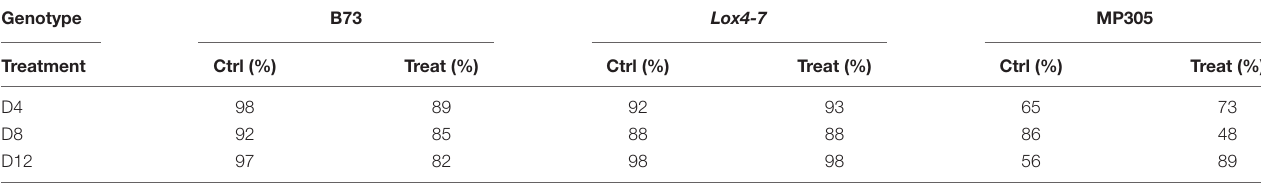
TABLE 6 | True positive rates of identifying control and treated plants based on Raman spectra of stalks from greenhouse-grown maize. Genotype B73 Lox4-7 MP305 Treatment Ctrl (%) Treat (%) Ctrl (%) Treat (%) Ctrl (%) Treat (%) D4 98 89 92 D8 85 88 82 98 56 89 TABLE 7 | True positive rates of identifying control and treated plants based on Raman spectra of stalks from field-grown maize. Genotype B73 Lox4-7 MP305 Treatment Ctrl (%) Treat (%) Ctrl (%) Treat (%) Ctrl (%) Treat (%) D4 72 81 69 D8 D12 91 86 Ctrl/D4 v D12* 87 77